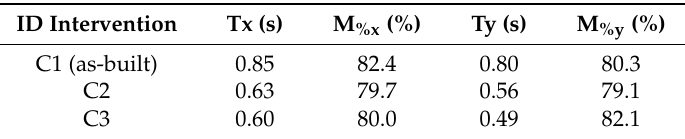
Table 5. Period of vibration and participating mass values for each building configuration evaluated for X- and